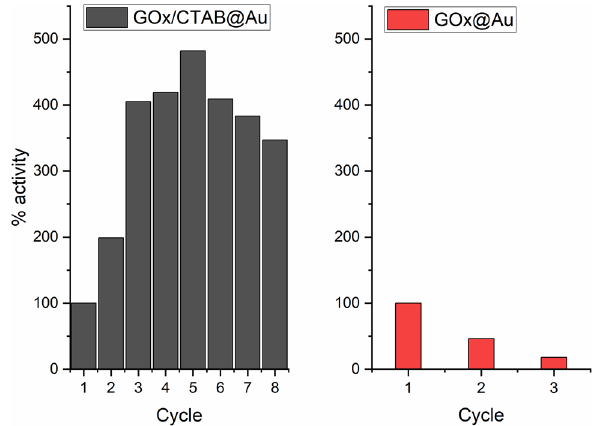
Figure 4. Recyclability of GOx/CTAB@Au (left) and of GOx@Au (right).